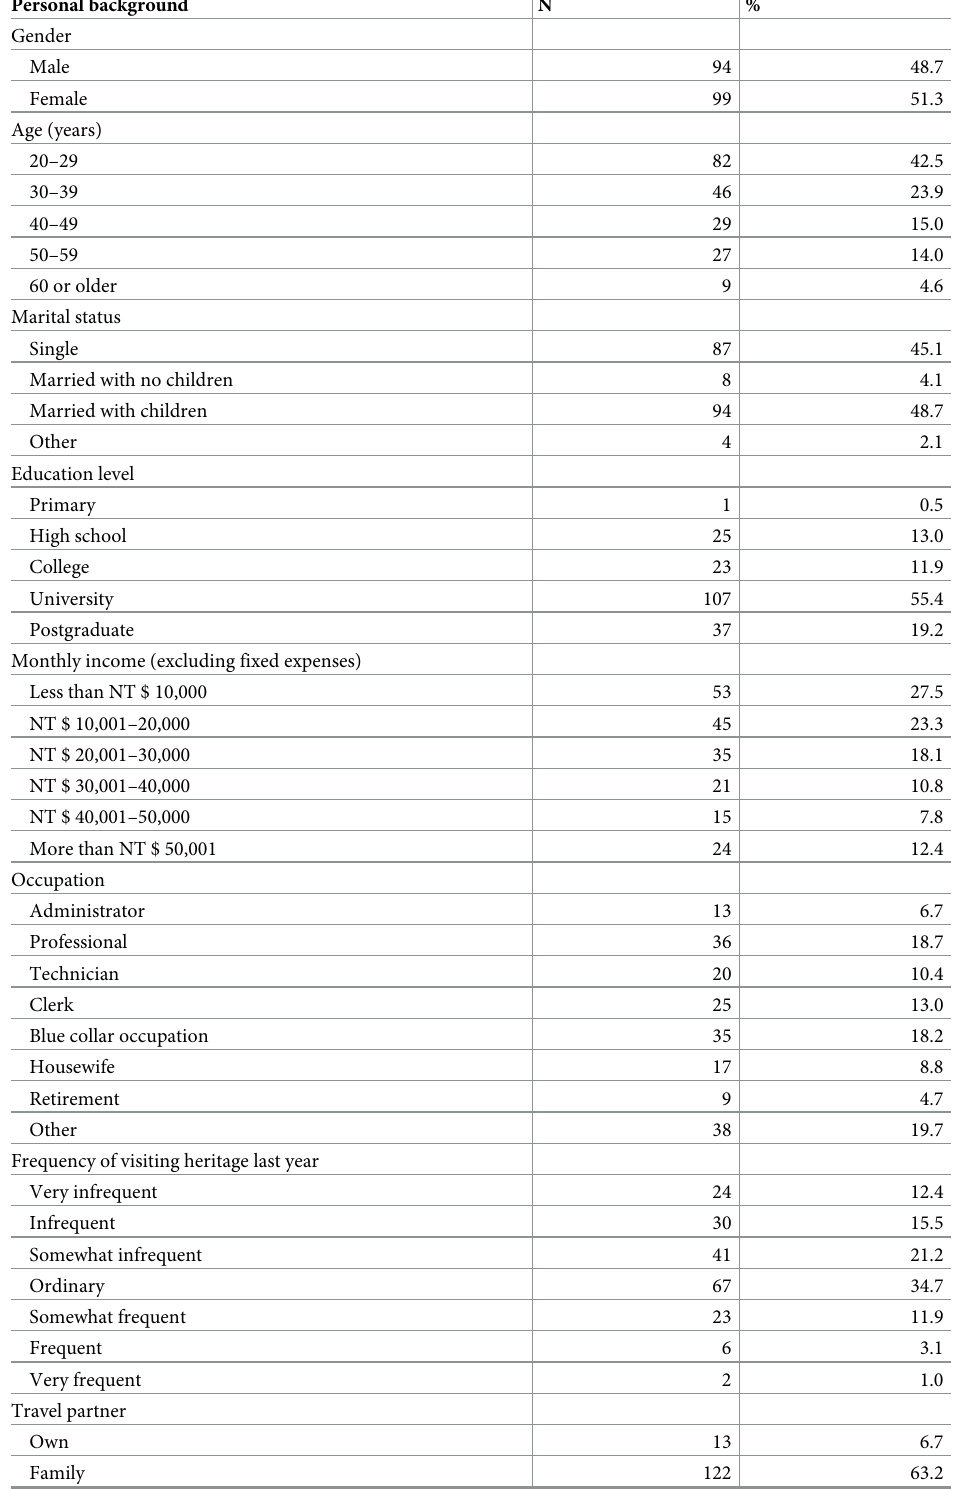
Table 2. The personal backgrounds of study